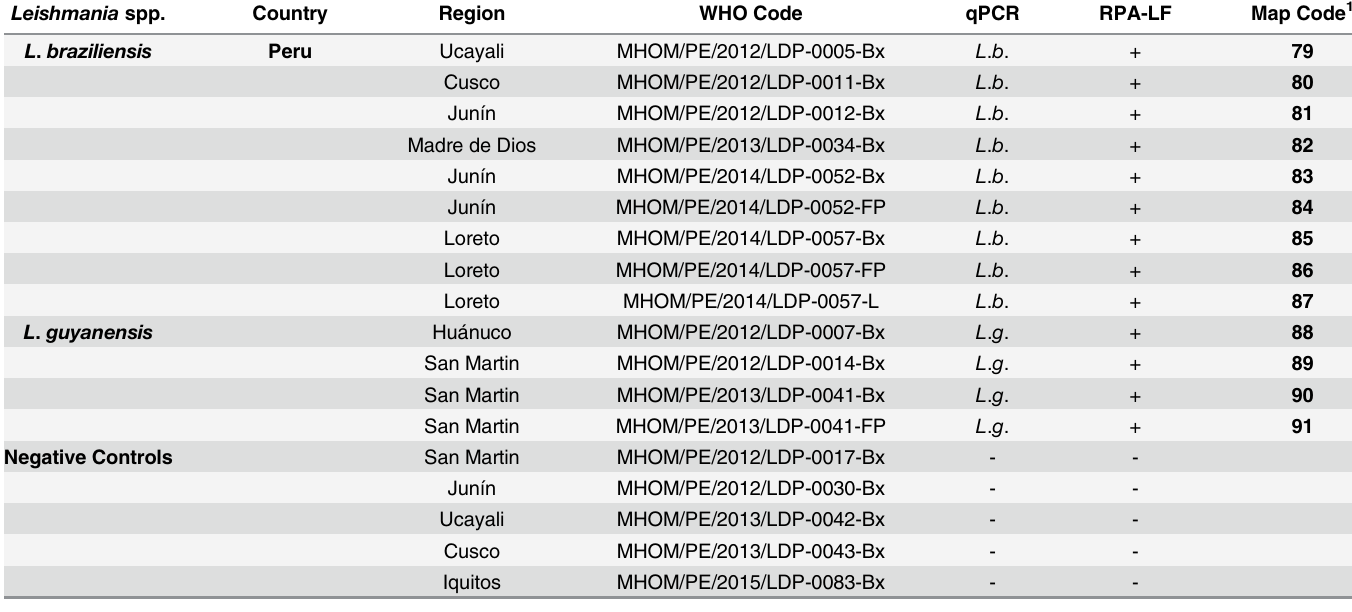
Table 2. Agreement between RPA-LF and PCR to amplify Leishmania Viannia DNA purified from lesions of cutaneous leishmaniasis patients from Peru. Leishmania